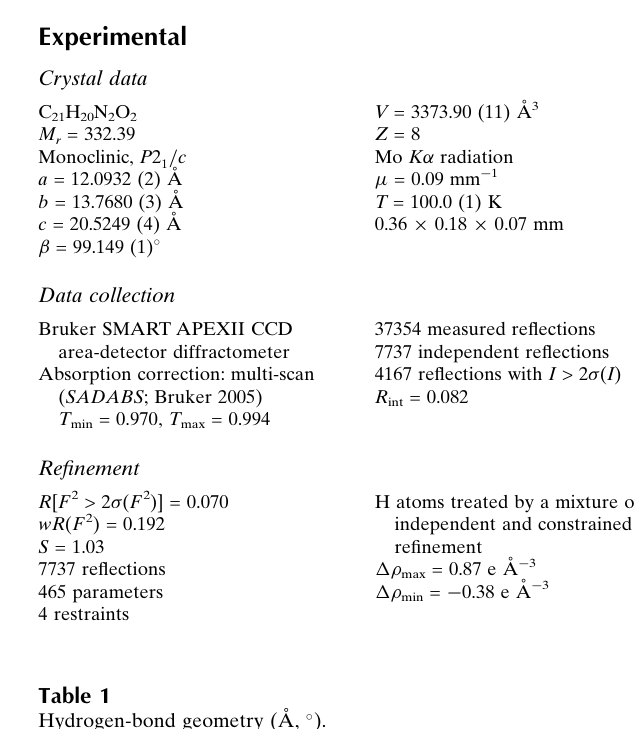
Hydrogen-bond geometry (A˚ , (cid:1)